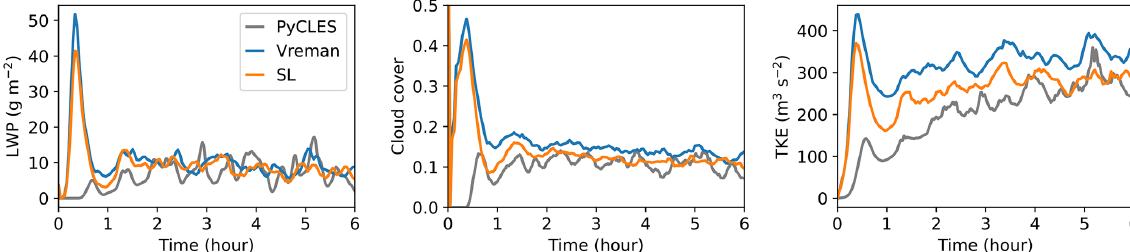
Figure 12. BOMEX. From left to right, time series of horizontally averaged LWP, cloud cover, and turbulence kinetic energy diagnosed from ClimateMachine using Vreman and SL. These results are consistent with ensemble results presented in Fig. 2 of the intercomparison study by Siebesma et al. (2003). Line colors are as in Fig. 11.